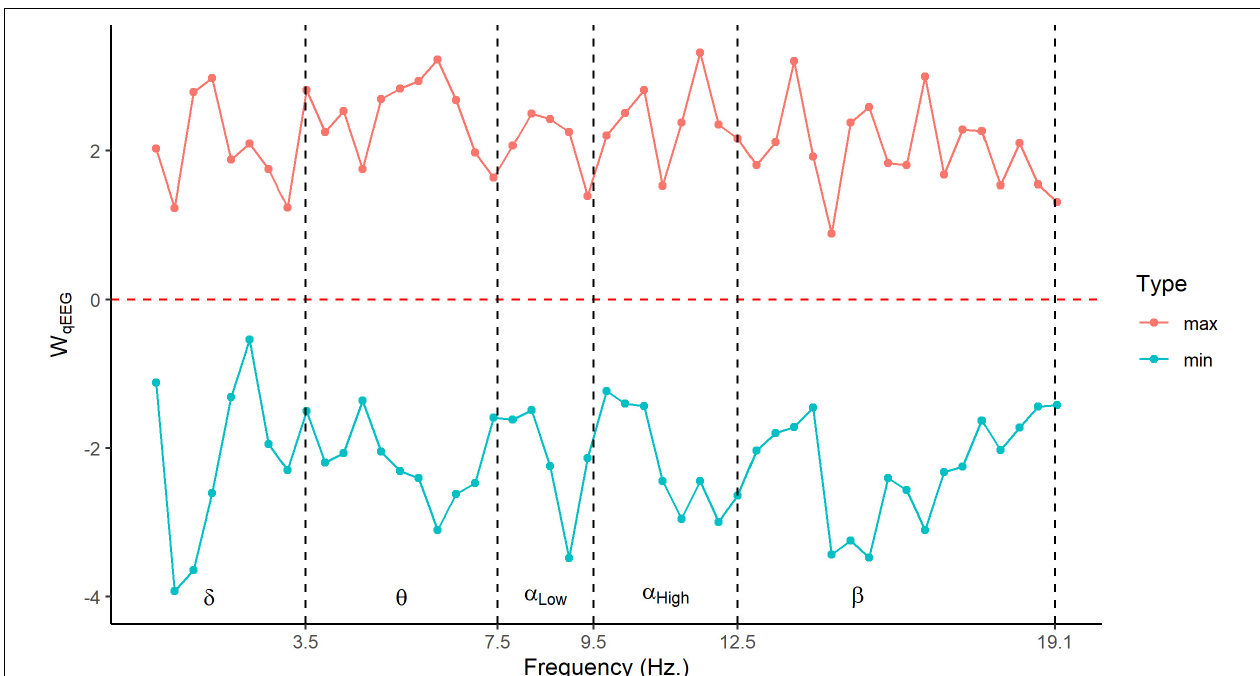
FIGURE 2 | Frequency marginal distribution of qEEG loading. Minimum and maximum loadings of W qEEG for 3,244 sources at each frequency point. The y -axis is pCCA loadings for scaled data, and the x -axis is the frequency in Hz. Here we are using the classic frequency bands: delta ( δ ) = 1–4 Hz, theta ( θ ) = 4–8 Hz, alpha